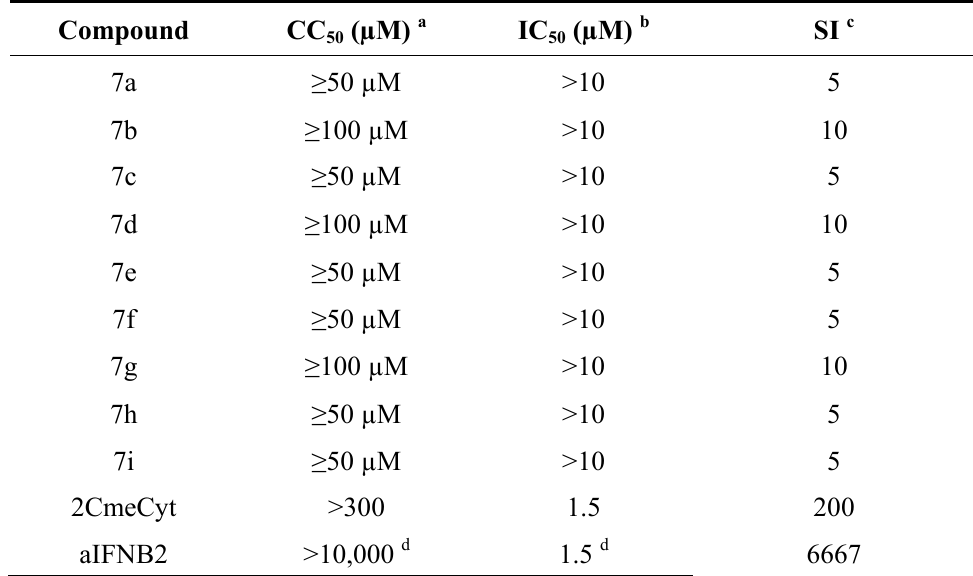
Table 2. Anti-HCV activity of compounds 7a – i